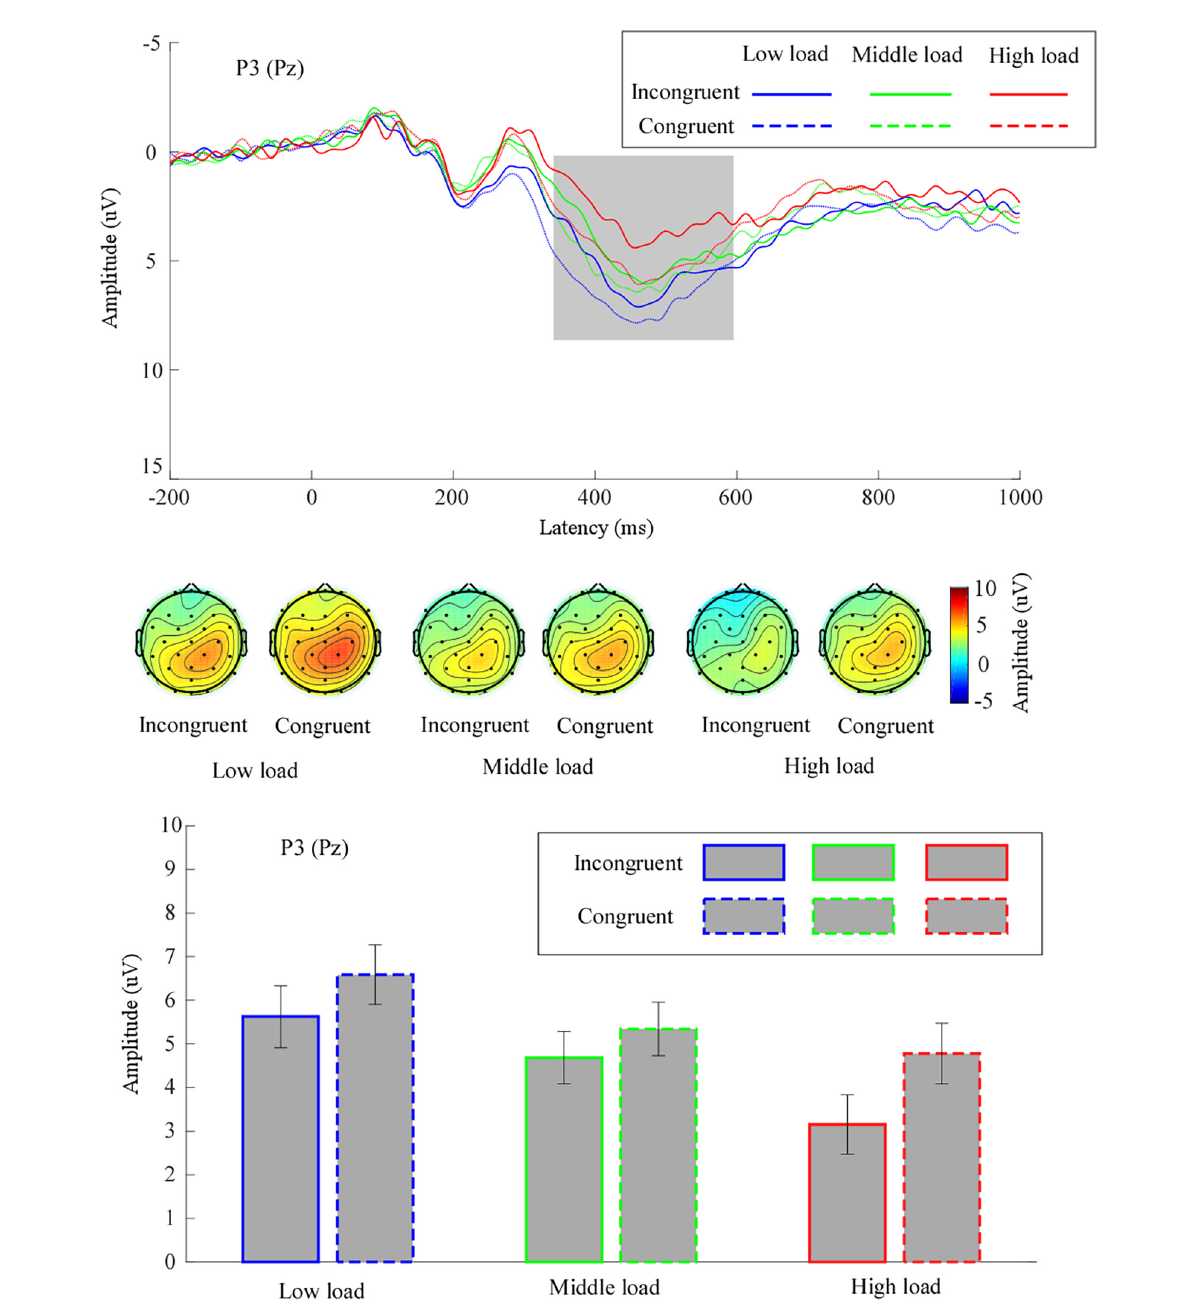
FIGURE4 The grand means of P3’s waveforms across different conditions at electrode site Pz. Further, the topography of P3 (time window: 350–600 ms) and mean values for P3 amplitude are given. Low load, low WM load; middle load, middle WM load; high load, high WM load.